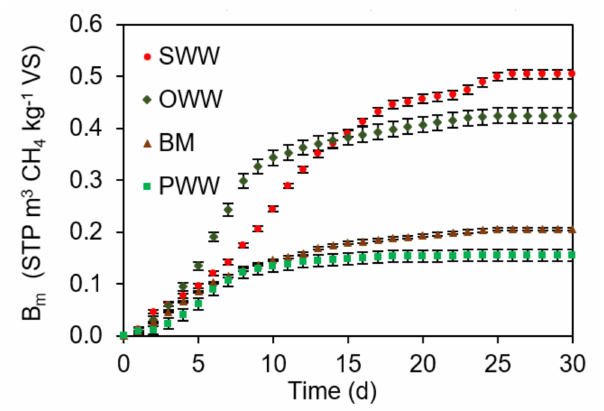
Figure 2. Accumulated CH 4 production of wastewater streams (SWW: slaughter wastewater; OWW: offal wastewater; PWW: paunch wastewater) and manure (BM) from a bovine slaughterhouse. BM resulted in a B o , at 30 days, of 0.206 ± 0.003 m 3 CH 4 kg − 1 VS and an f d of 0.46 ± 0.00, which are in the range of B o values reported for dairy manure (0.089–0.303 m 3 CH 4 kg − 1 VS) [44,45] and close to the biodegradability published in previous studies (0.54) [22]. PWW resulted in a B o and an f d of 0.154 ± 0.011 m 3 CH 4 kg − 1 VS and 0.34 ± 0.01, respectively. These values are lower than those found for PWW in Australian slaughter- houses (0.309 m 3 CH 4 kg − 1 VS and 0.84) [13]. Since the composition of ruminal